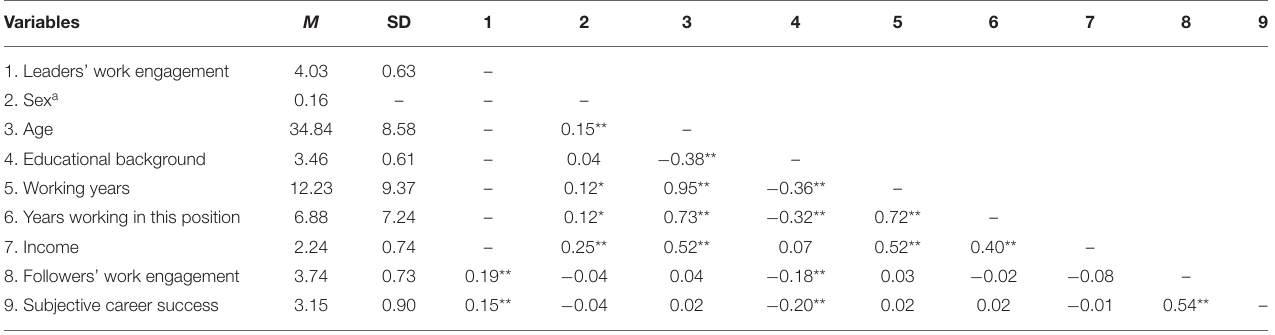
TABLE 1 | Descriptive statistics.